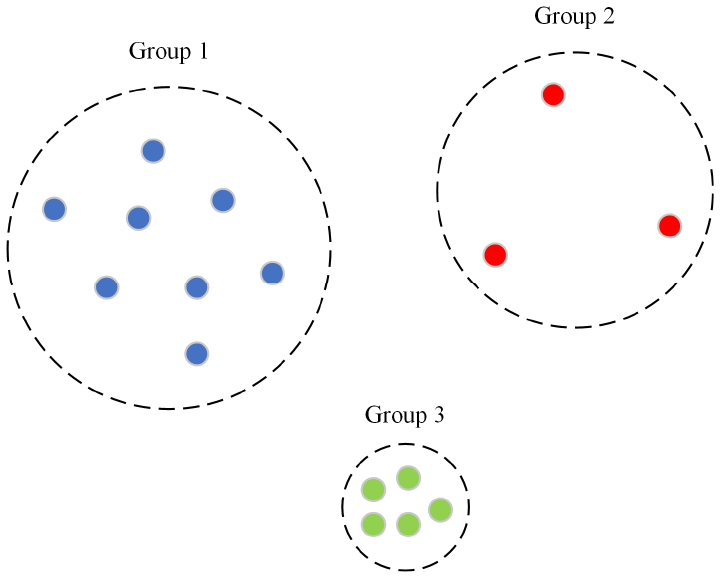
Figure 4. Example of density-based clustering.